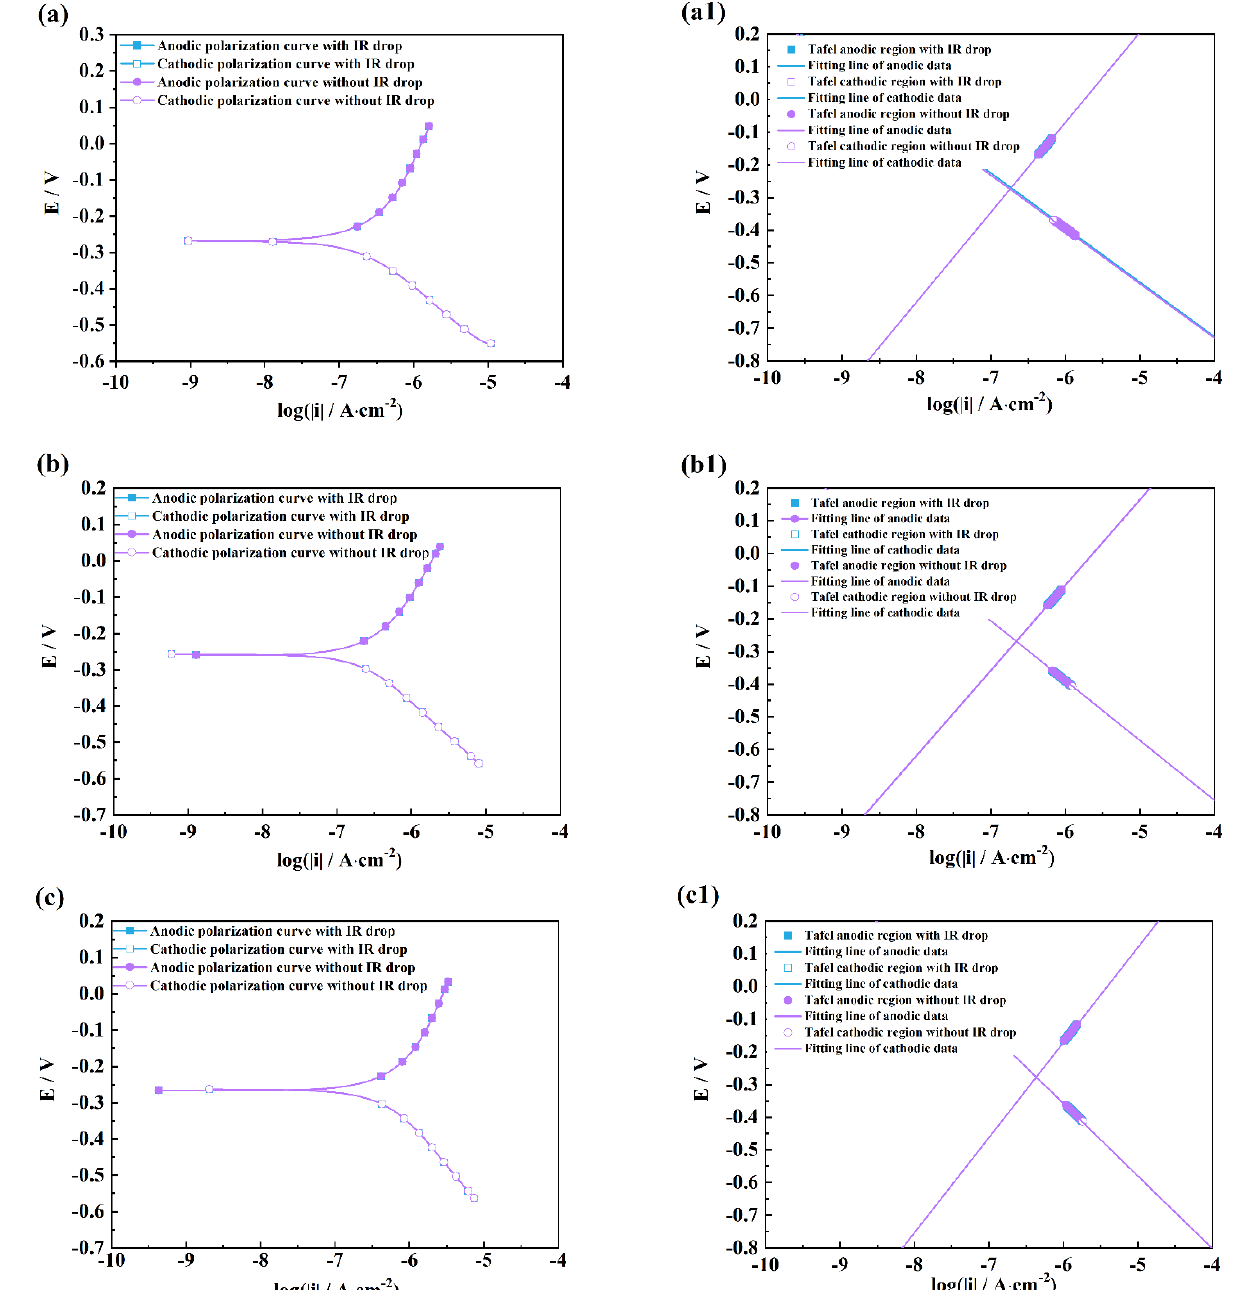
Figure 7. Comparison of polarization curves with and without an IR drop of M1 ( a ), M2 ( b ), M3 ( c ) and linear fitting plots of the Tafel regions of M1 ( a1 ), M2 ( b1 ), M3 ( c1 ) in NaOH solutions after 2h exposure. Table 3. Fitting results of polarization curves with and without an IR drop by Tafel extrapolation under three measurements in HCl solutions after exposure for 2h.